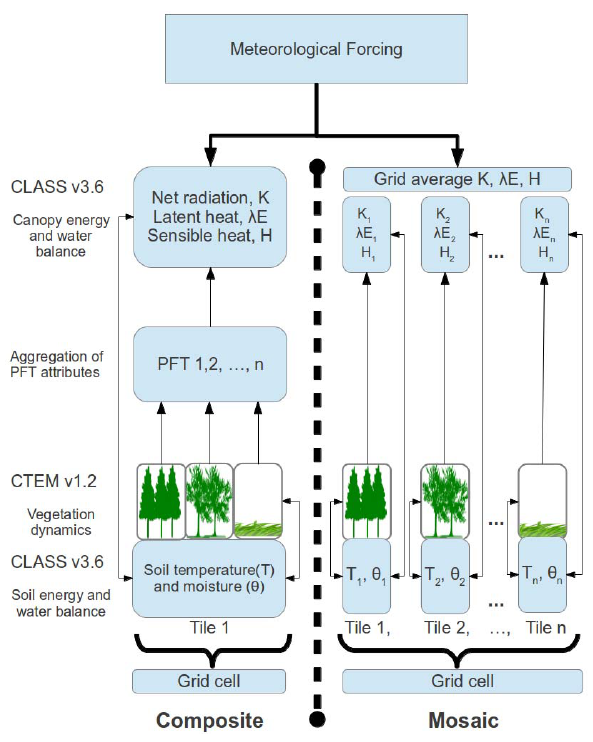
Fig. 1. Schematic representation of the composite and mosaic ap- proaches for the coupling of CLASS v 3.6 and CTEM v 1.2 models in a stand-alone